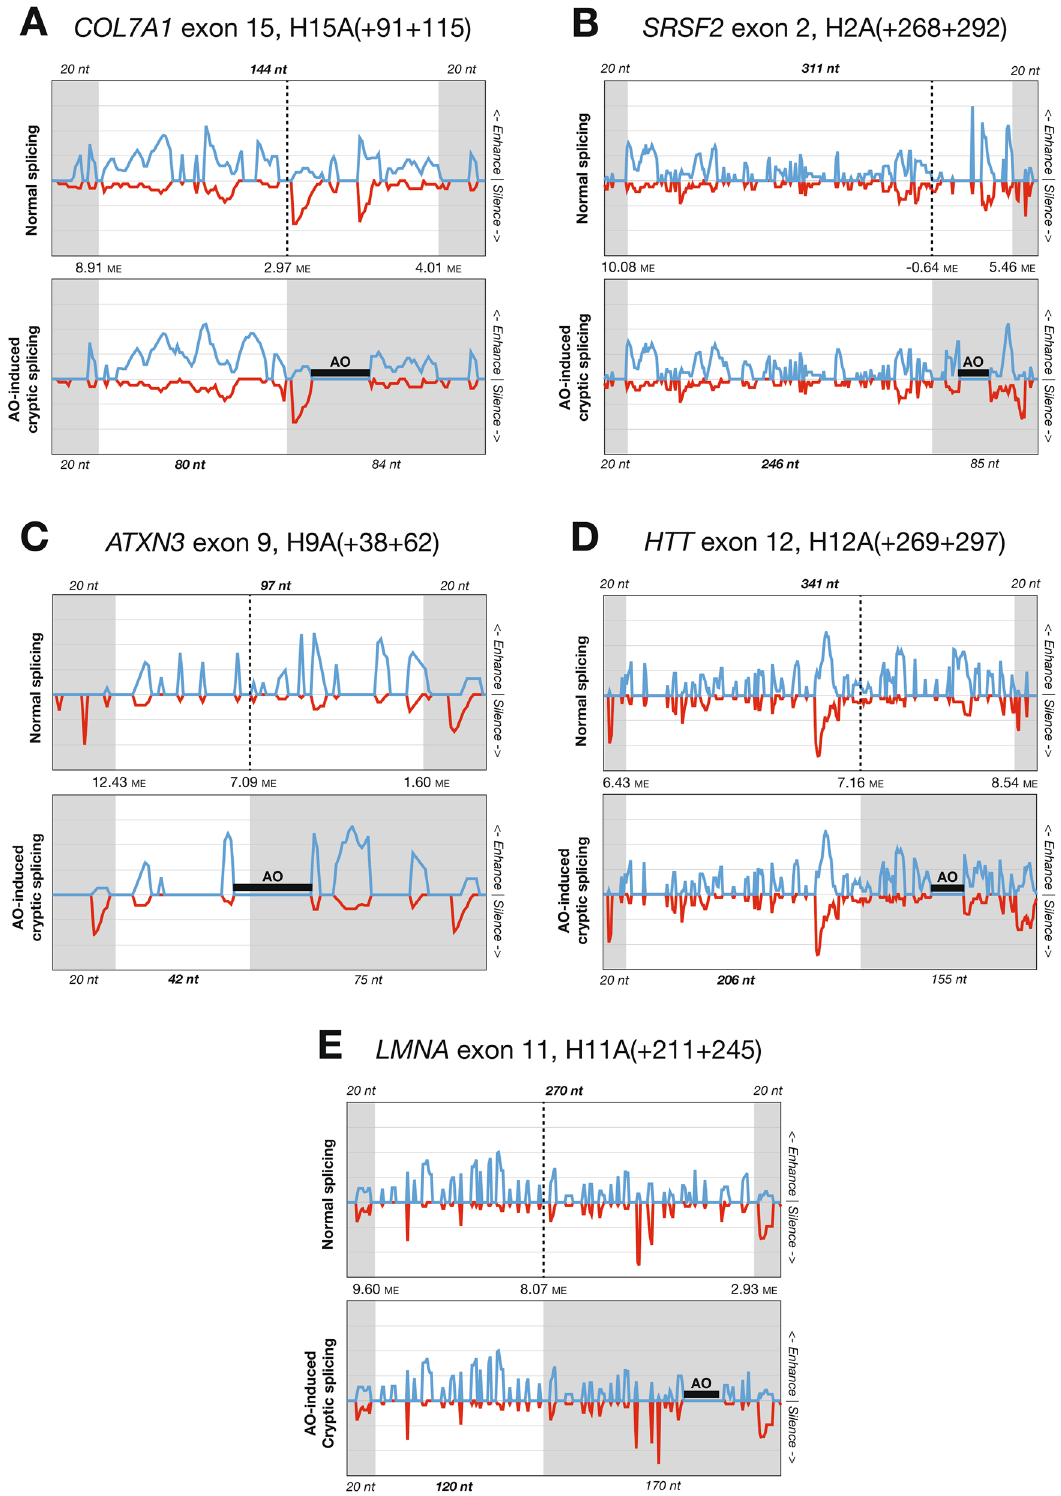
Figure 2. Changes to predicted exon splicing enhancer/silencer (ESE/ESS) access in five examples of antisense oligonucleotide (AO)-induced cryptic splicing of canonical exons. Blue lines indicate ESE access and red lines indicate ESS access. Grey shading indicates pre-mRNA sequence excluded from the mature transcript. Region sizes and Maximum Entropy scores for cryptic and canonical splice sites are also